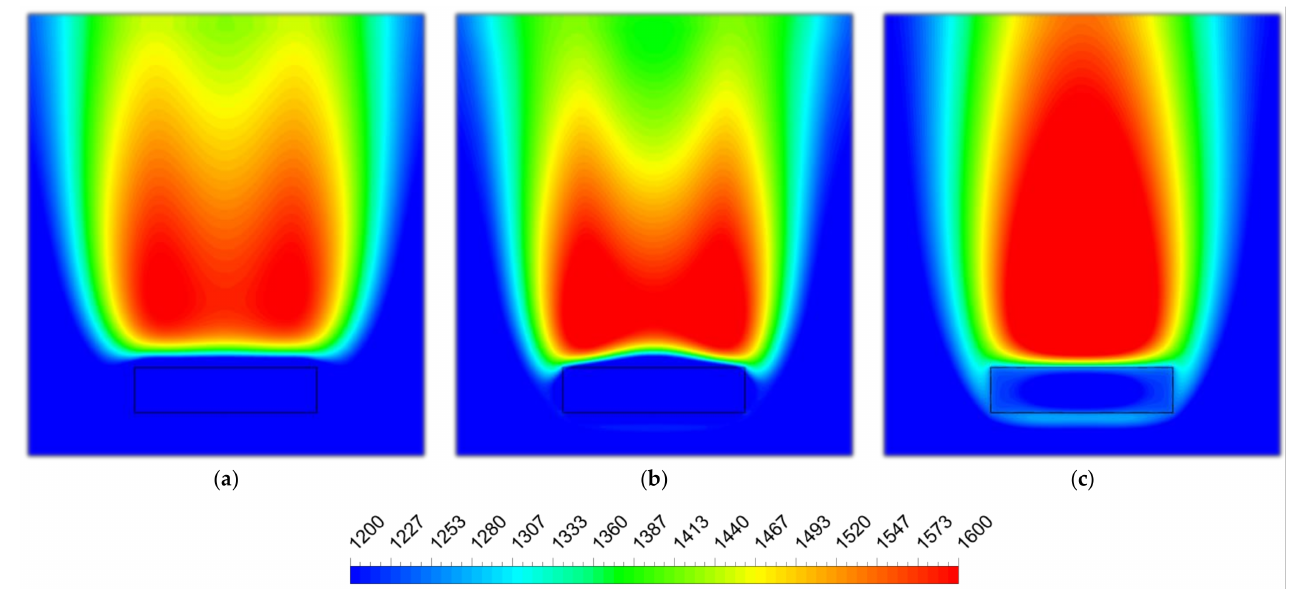
Figure 20. Temperature (in K) distribution at ( a ) t = 25 s, ( b ) 40 s and ( c ) 75